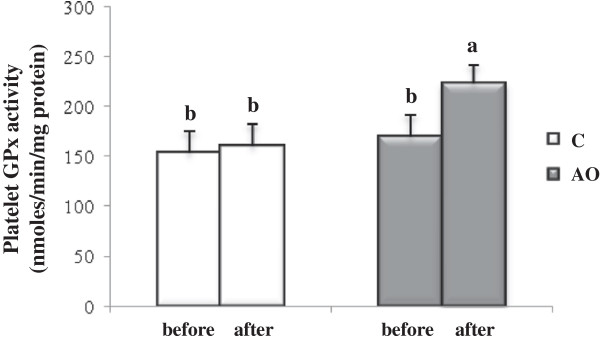
Platelet glutathione peroxidase (GPx) activity after 3 weeks of nutritional intervention with argan oil. Comparisons are made between the platelet GPx activity before and after the intervention period in the two groups. C: control group; AO: argan oil group. After a one-way ANOVA, Student-Newman-Keuls multiple comparison test, results are arranged in increasing order from left to right a > b (p < 0.05).